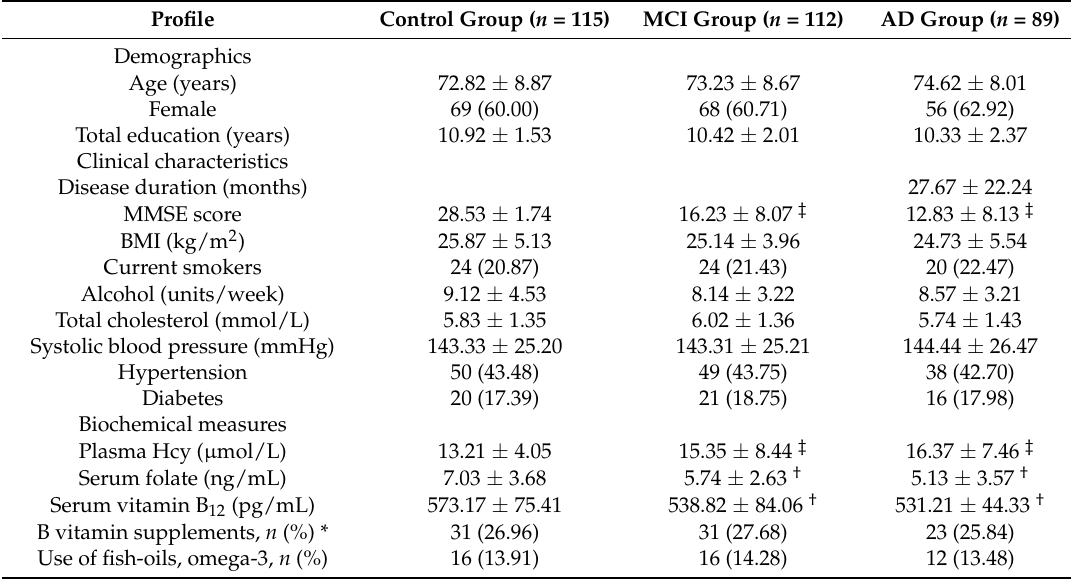
Table 1. Demographic, clinical, and biochemical characteristics of the three